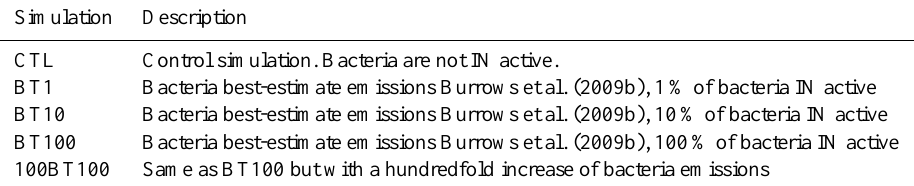
Table 1. Simulations.